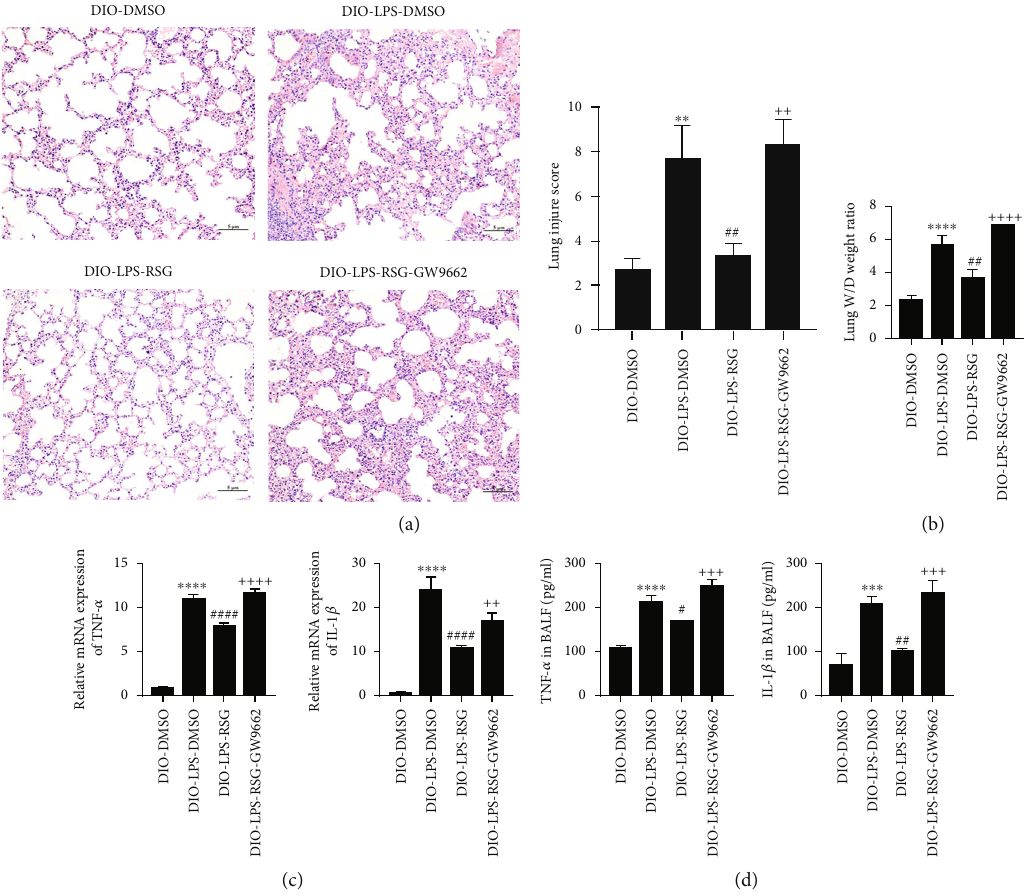
Figure 6: Activation of PPAR γ attenuated LPS-induced lung injury in obese mice. (a) HE-stained sections of lung tissue and lung injure score (original magni fi cation, × 200). (b) Wet/dry weight ratio of lungs. (c) Relative mRNA expressions of TNF- α and IL-1 β in lung tissue. (d) Determination of TNF- α and IL-1 β levels in BALF by ELISA. Data are presented as mean ± SD . ∗∗ p < 0 : 01 , ∗∗∗ p < 0 : 001 , ∗∗∗∗ p < 0 : 0001 vs. DIO-DMSO, # p < 0 : 05 , ## p < 0 : 01 , #### p < 0 : 0001 vs. DIO-LPS-DMSO, ++ p < 0 : 01 , +++ p < 0 : 001 , ++++ p < 0 : 0001 vs. DIO-